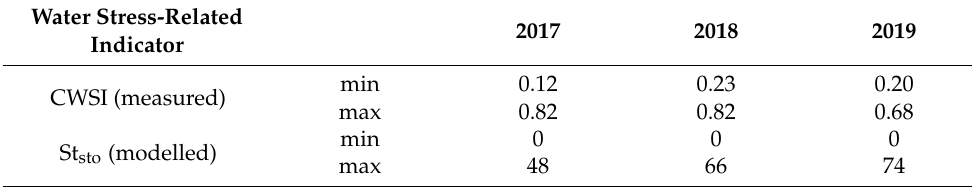
Table 7. Minimum and maximum values of the measured and simulated water stress-related indicators.